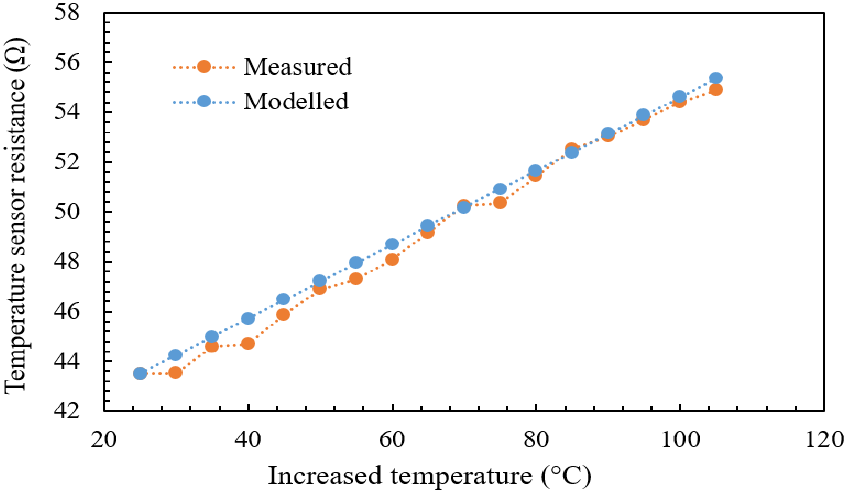
Figure 15. Modeled and experimental for the temperature sensor (gold) versus increasing